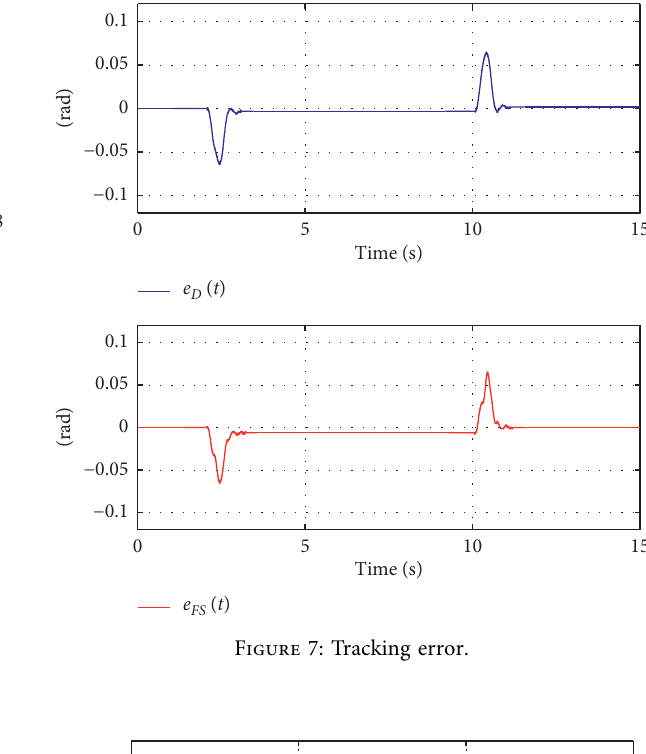
Figure 5: Root locus.